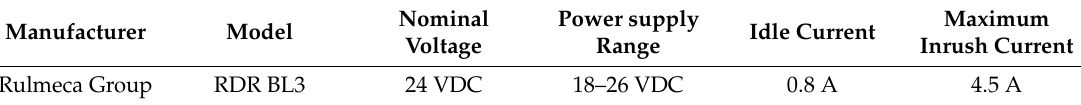
Table 2. Technical parameters of the motor, used in the experiment.